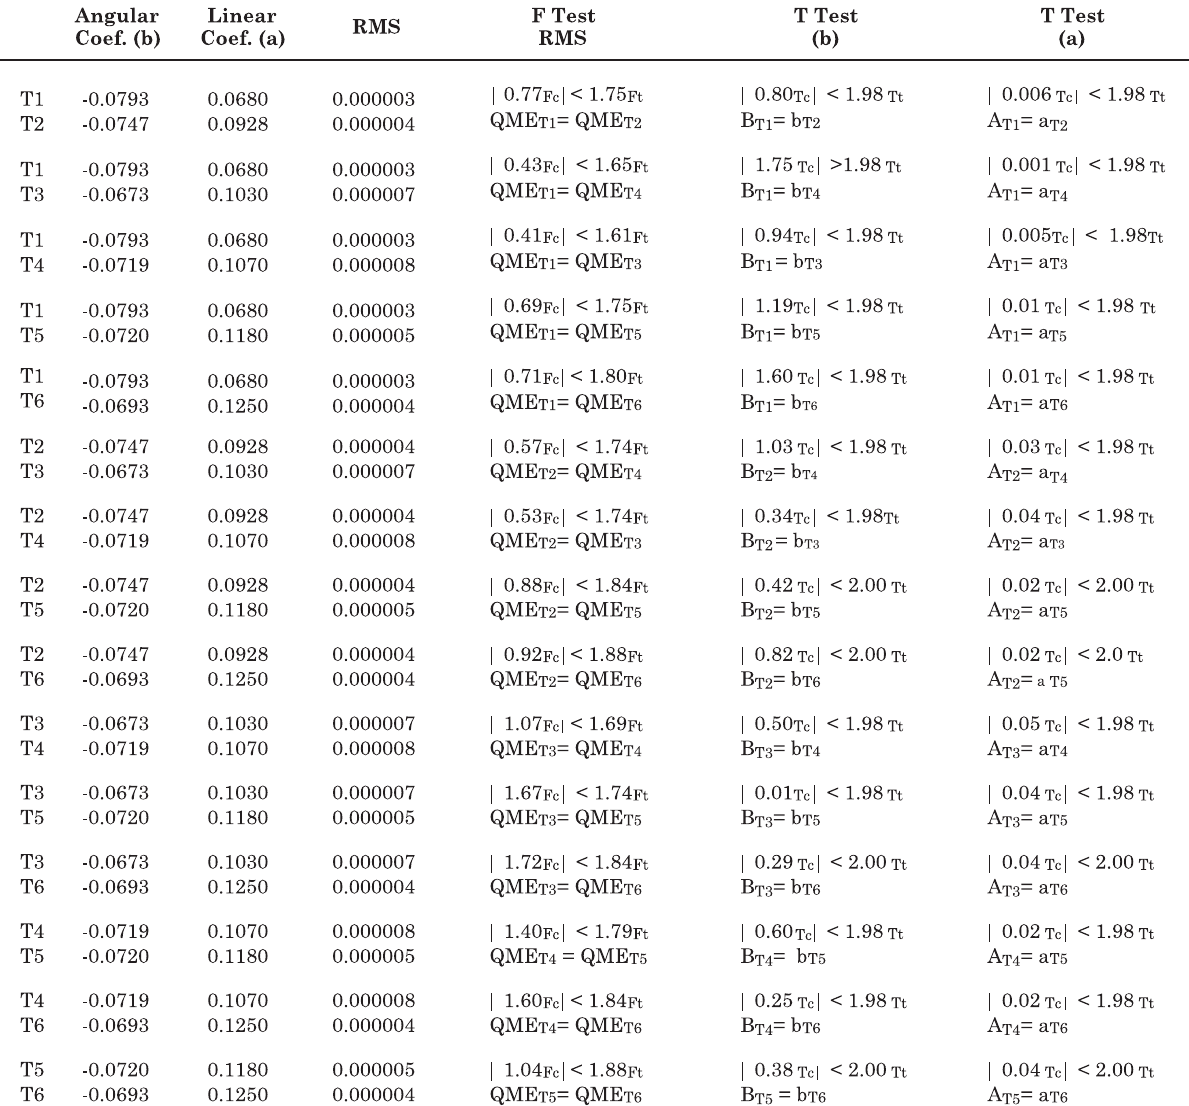
Table 3. Comparison test of the angular and linear coefficients of graphs of wastewater